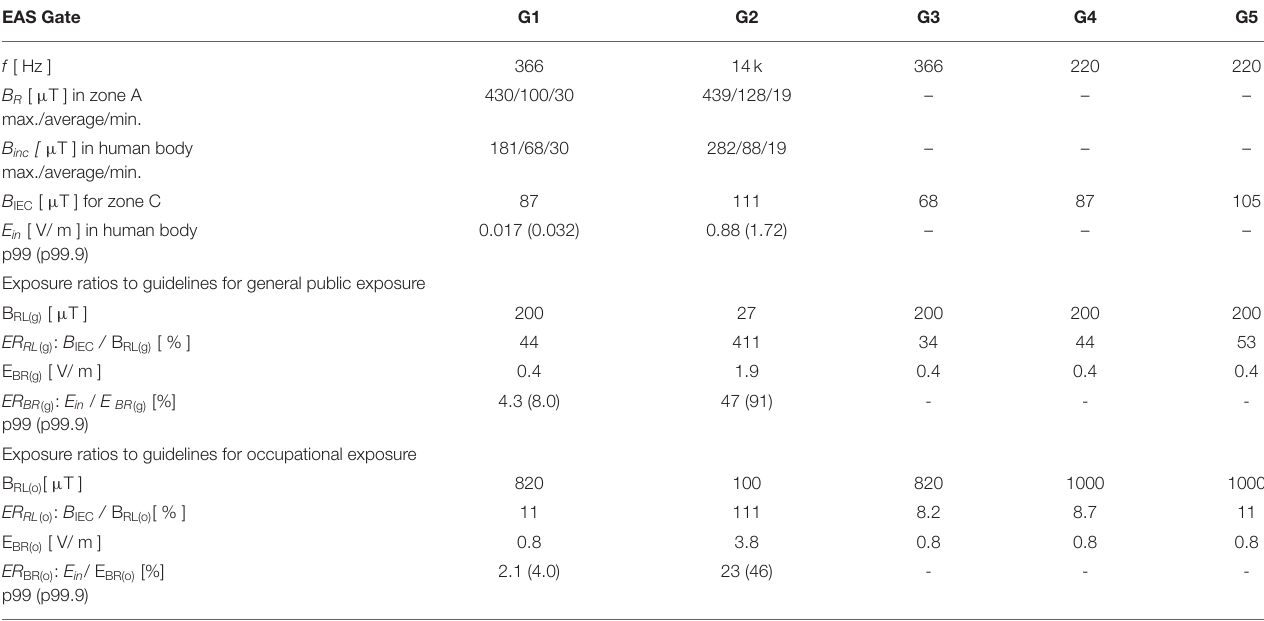
TABLE 3 | Summary of exposure characteristics.